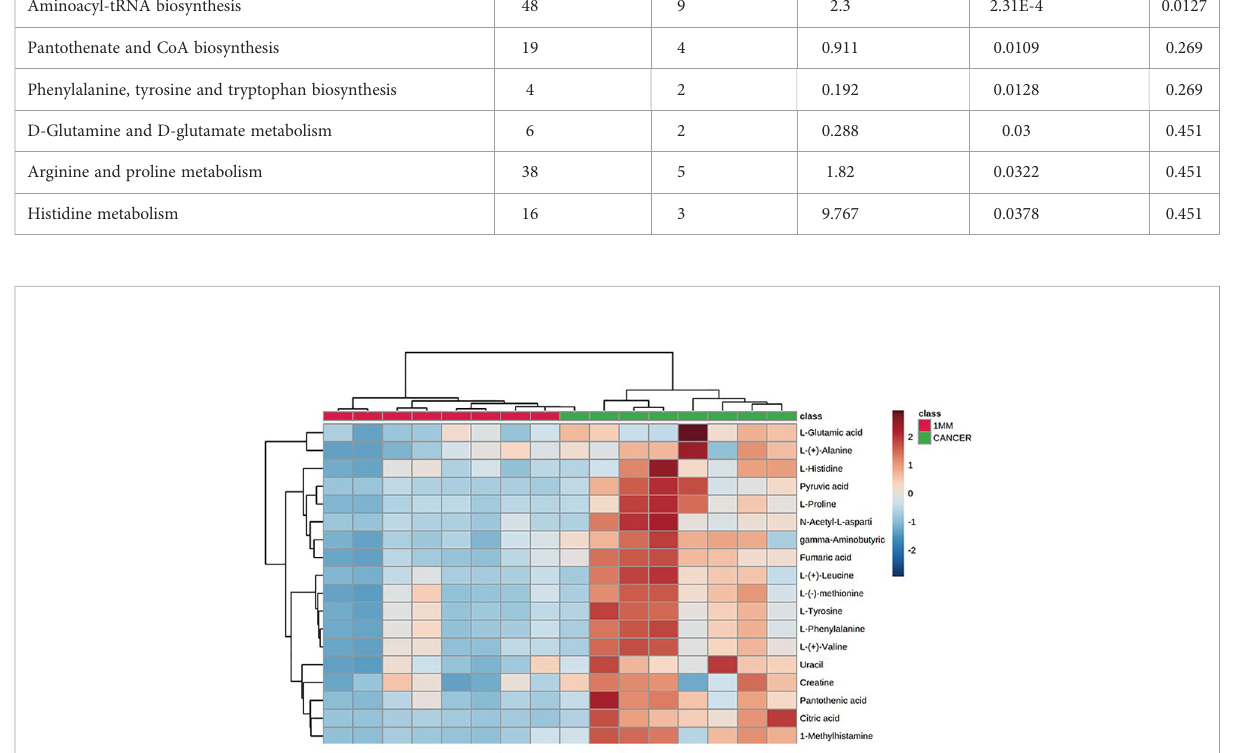
FIGURE 4 Heatmap indicating the relative levels of statistically signi fi cant differential metabolites in 1-mm cut edge tissue and cancerous tissue.